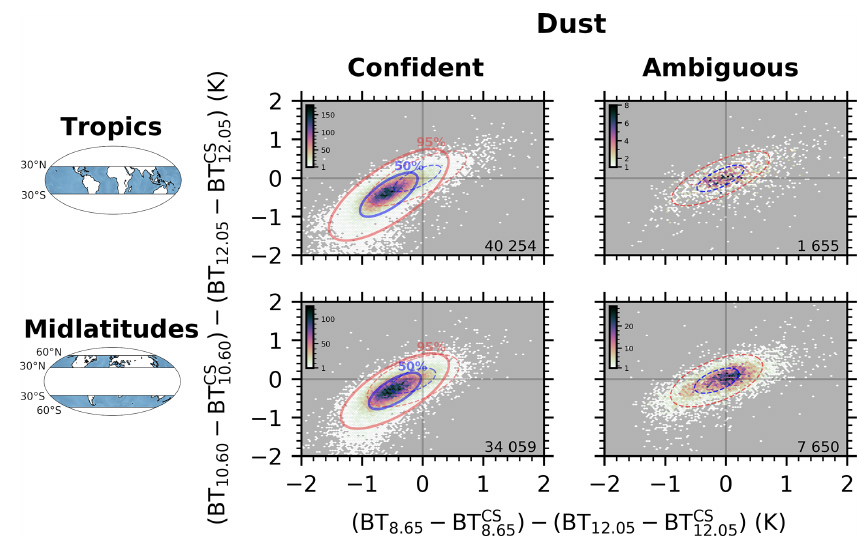
Figure 8. As Fig. 7 for dust monolayer observations with τ < 0 . 2 and 4km < z top <